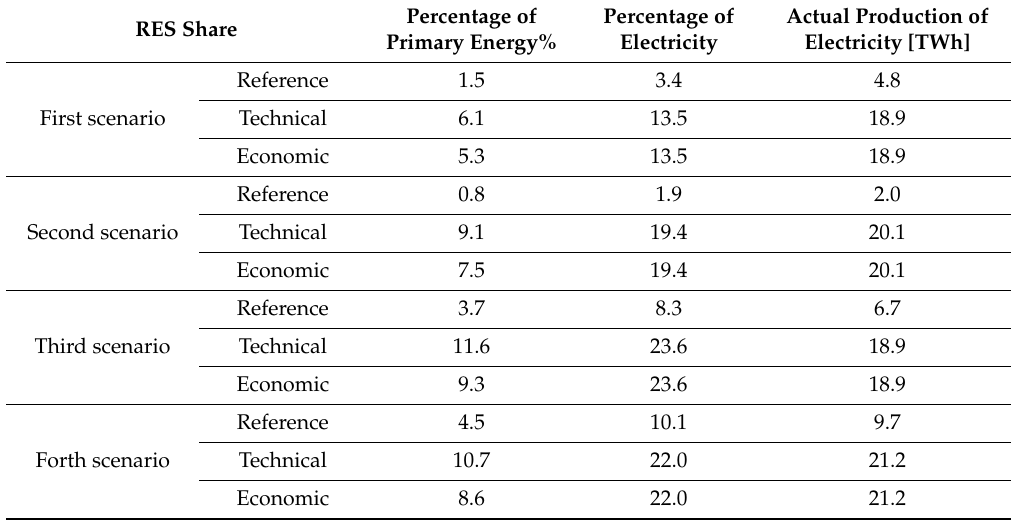
Table 17. Percentage of primary energy, percentage of electricity, and actual production of electricity of the-various scenarios